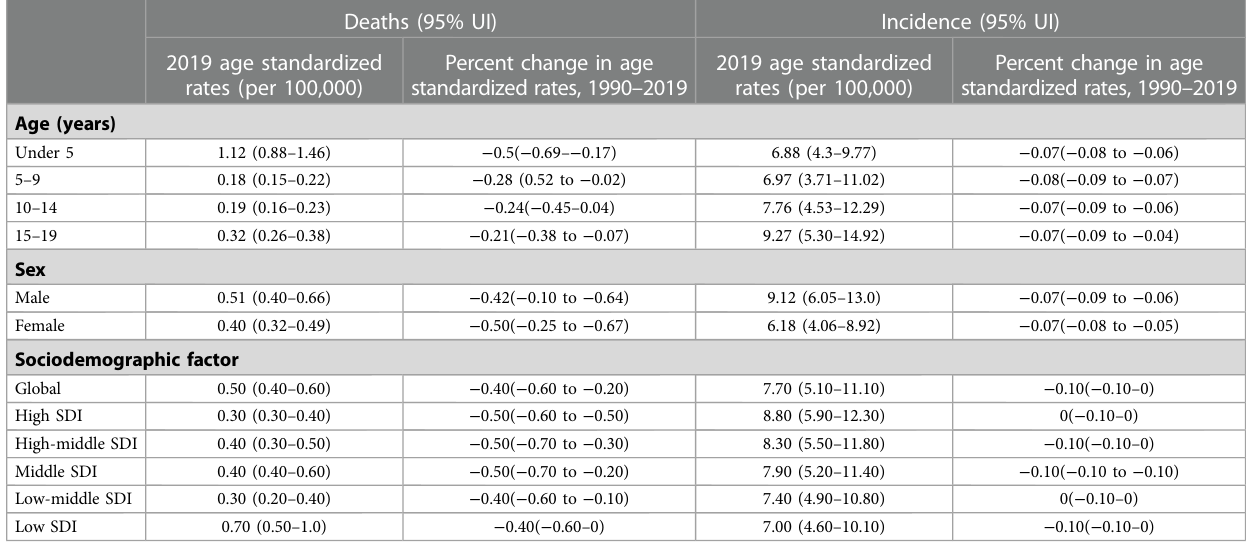
TABLE 1 Percent change in age-standardized rates of childhood myocarditis and cardiomyopathy by age group, sex and SDI, 1990 – 2019.